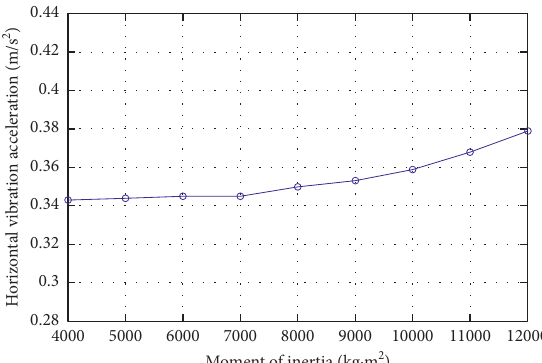
Figure 5: Influence of moment of inertia of the car system on horizontal